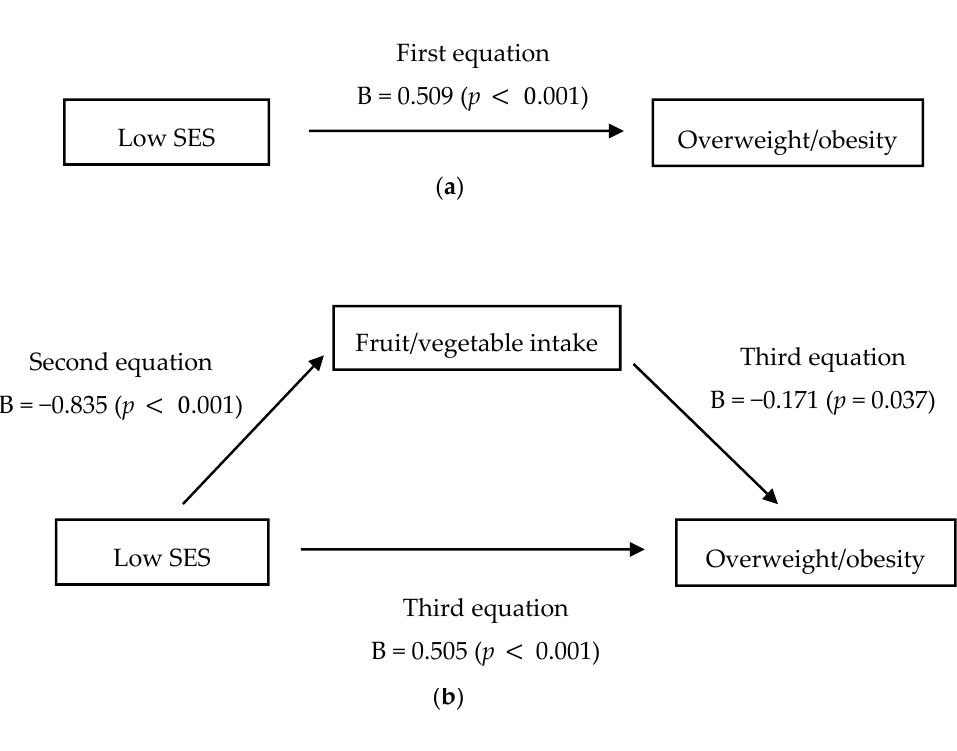
Figure 1. Adolescent overweight/obesity linked to socioeconomic status and fruit and vegetable intakes in adolescent girls: Testing for a mediating effect of fruit/vegetable intakes on the association between SES and overweight/obesity using a logistic regression analysis ( a ) Direct pathway from low SES to overweight/obesity; ( b ) Indirect pathway from low SES to overweight/obesity via fruit/vegetable intakes. B: standardized regression coefficient